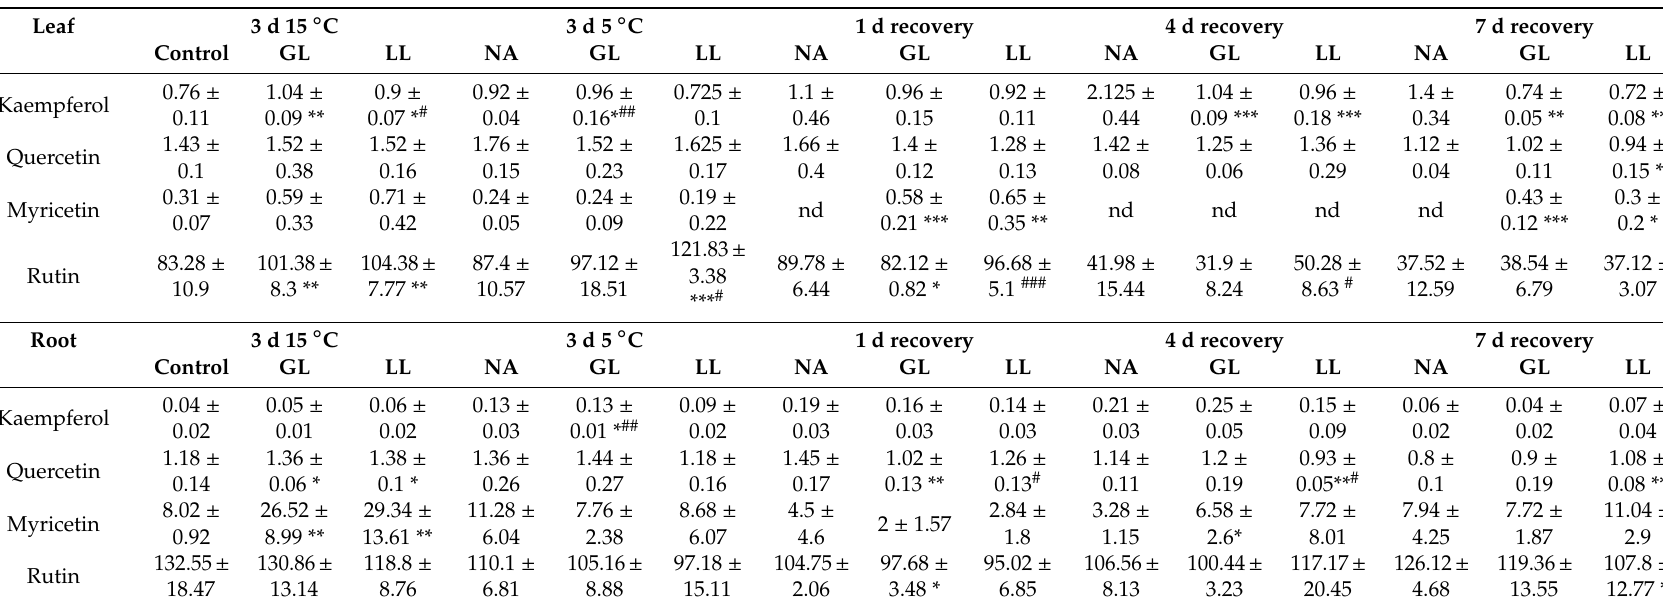
Table 1. Changes in the flavonol contents during cold acclimation (15 / 13 ◦ C), chilling (5 ◦ C) and recovery in the leaves and roots of young maize plants.